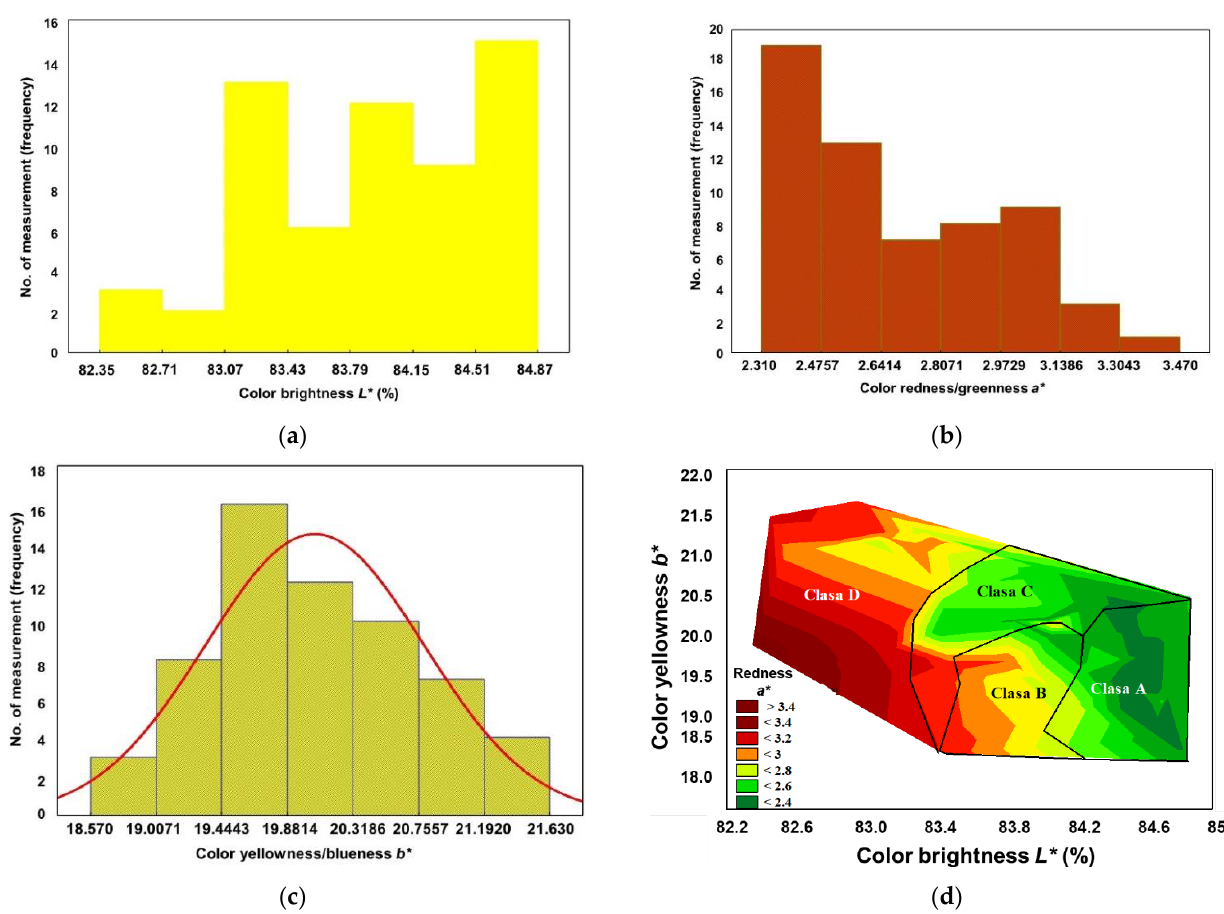
Figure 6. Distribution of the color components for resonant wood: ( a ) color brightness; ( b ) color redness; ( c ) color yellowness; ( d ) color spectrum of spruce samples measured, according to quality class.